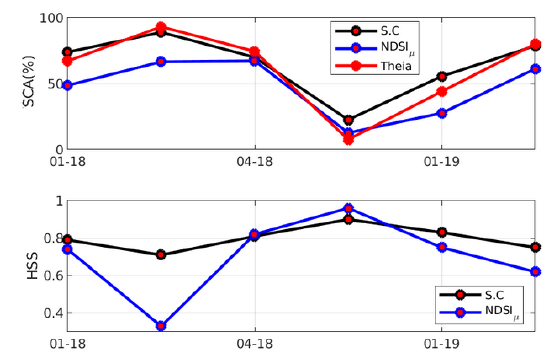
Figure 5. Results for the VEN µ S tile: temporal evolution of the snow cover fraction (SCA%) and HSS from the supervised classification (SC), NDSI µ and the Theia snow product (used as a reference). The size of the tile is: 32.27 × 73.24 km 2